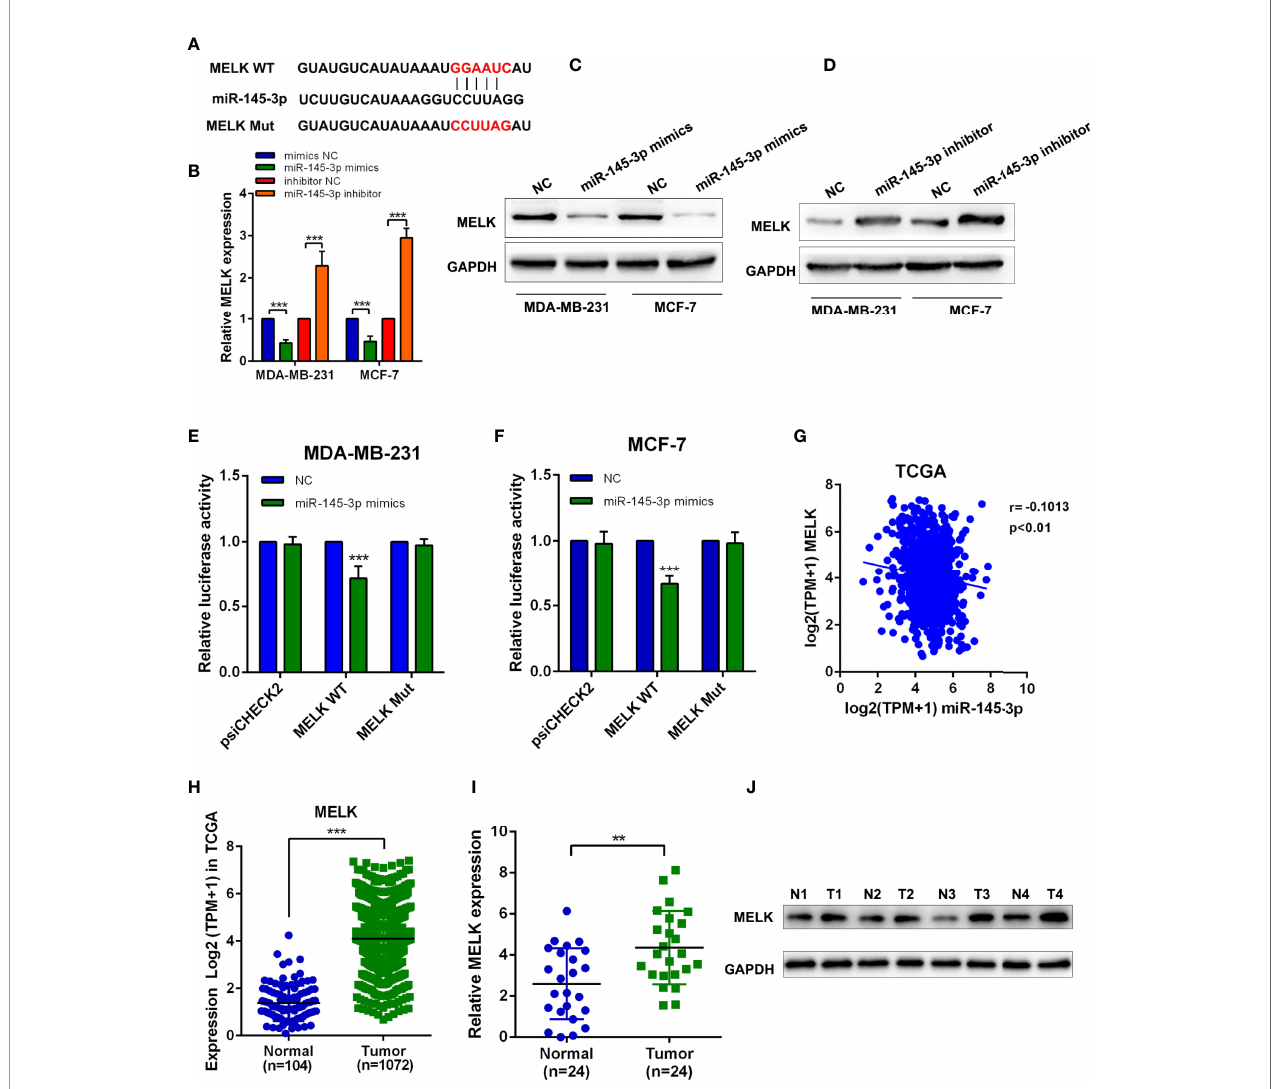
FIGURE 6 | MiR-145-3p suppresses MELK in breast cancer cells (A) The predicted miR-145-3p binding sites in the MELK transcript. (B) The expression of MELK was detected in MDA-MB-231 and MCF-7 cells transfected with miR-145-3p mimics or miR-145-3p inhibitor by RT-qPCR. (C, D) The expression of MELK was detected in MDA-MB-231 and MCF-7 cells transfected with miR-145-3p mimics or miR-145-3p inhibitor by western blot. (E, F) The luciferase activities in MDA-MB- 231 and MCF-7 cells co-transfected with wild-type (WT) or mutant MELK plasmid together with miR-145-3p mimic or miR-NC (G) Correlation between MELK and miR-145-3p expression based on the TCGA analysis. (H) MRNA expression level of MELK in breast cancer samples and normal tissues from TCGA database (I) MRNA expression level of MELK in breast cancer samples and normal tissues by RT-qPCR assays. (J) The protein level of MELK in breast cancer samples and normal tissues from western blotting. ** P < 0.01, *** P <